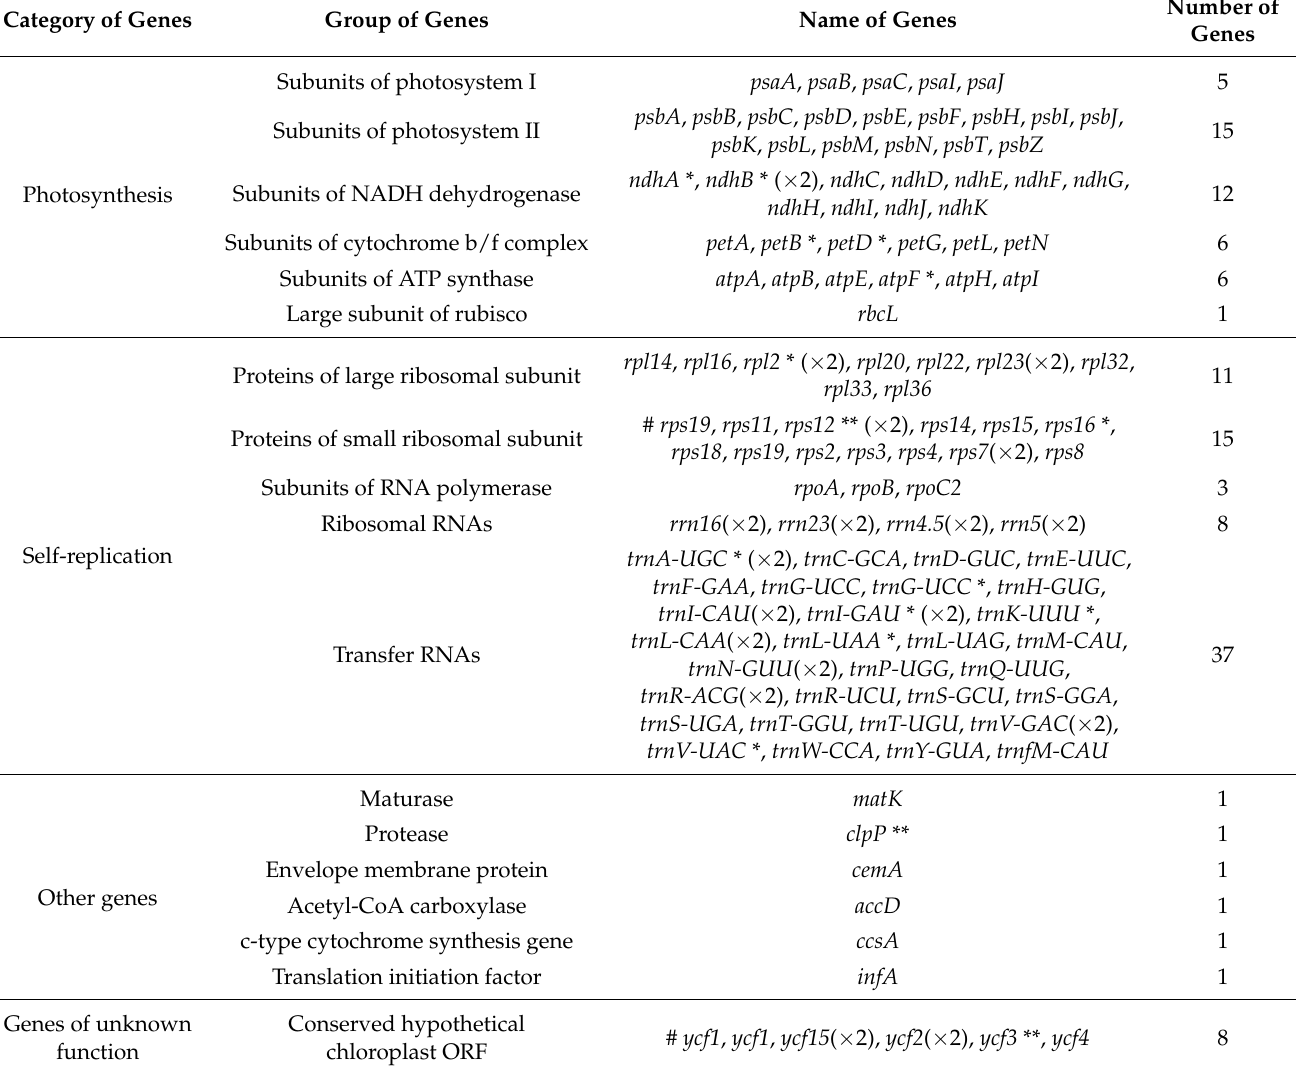
Table 2. List of genes found in the two cp genomes of Parasenecio